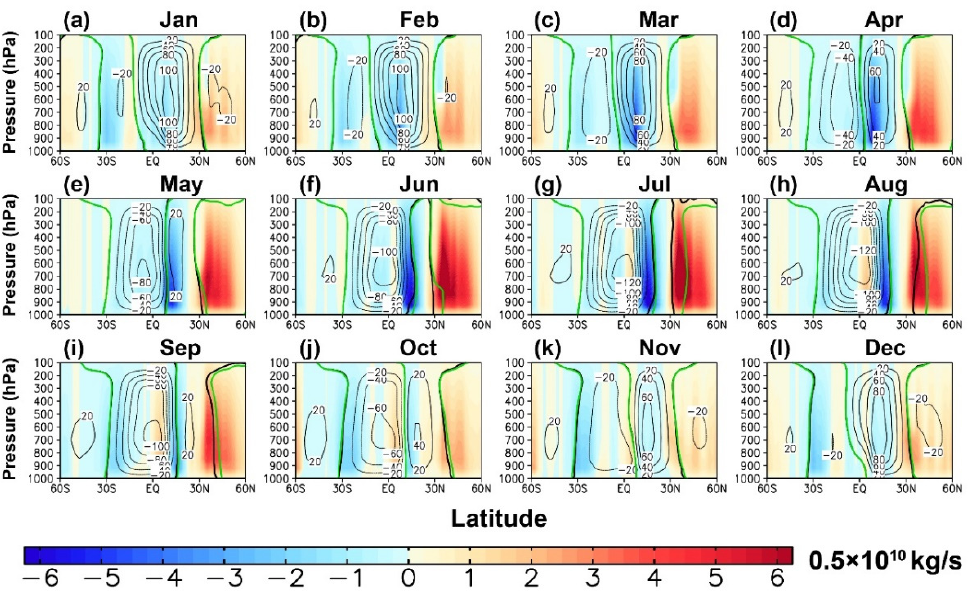
Atmosphere 2020 , 11 , x FOR PEER REVIEW Figure 4. Same as Figure 3 but for the results derived from M2. Figure 4. Same as Figure 3 but for the results derived from M2.